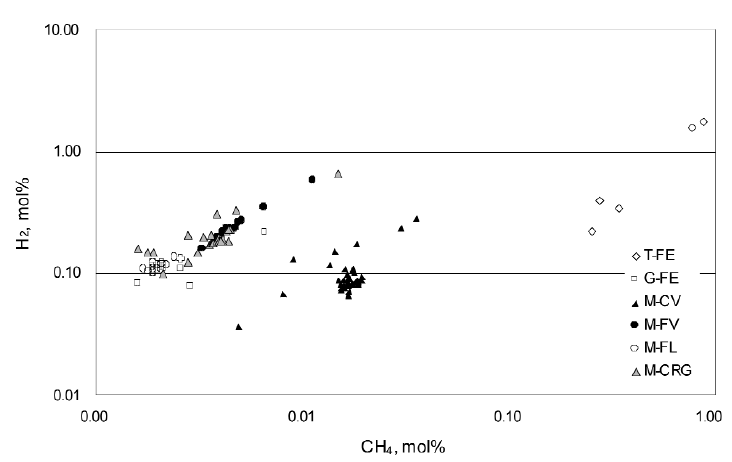
Fig. 6. H 2 /CH 4 relation for the fumaroles under monitoring at the Azores Archipelago. References as in